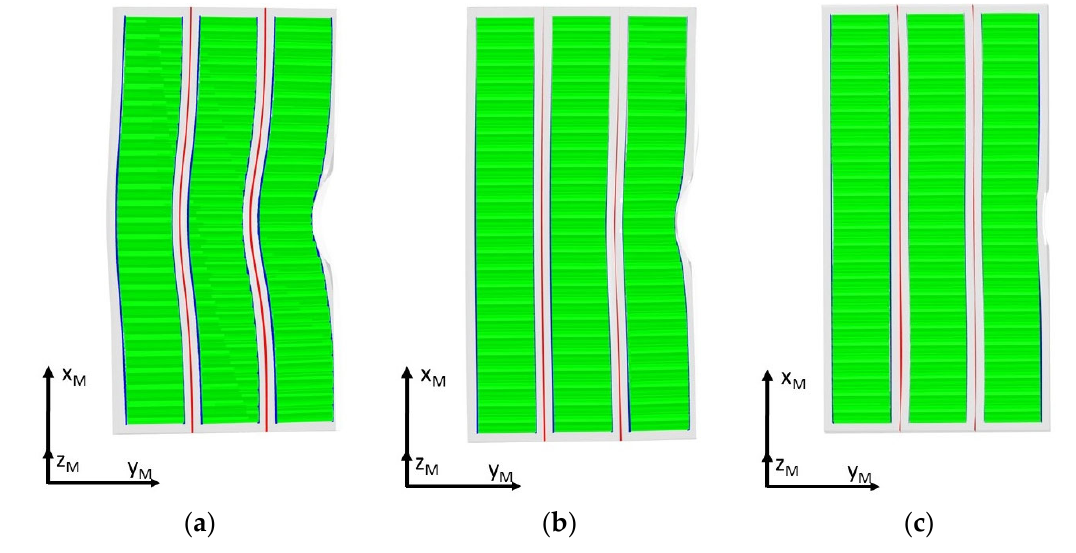
Figure 6. Traction battery deformation for Concept Y with cell B at 6.5 ms after impact for: ( a ) EPs’ thickness of 3 mm and LPs’ thickness of 3 mm, ( b ) EPs’ thickness of 3 mm and LPs’ thickness of 20 mm, and ( c ) EPs’ thickness of 20 mm and LPs’ thickness of 3 mm. Note that the EPs are semi-transparent. The error distributions in ISCR between the FE model of Concept Y with cells A and B are proven to be normal.